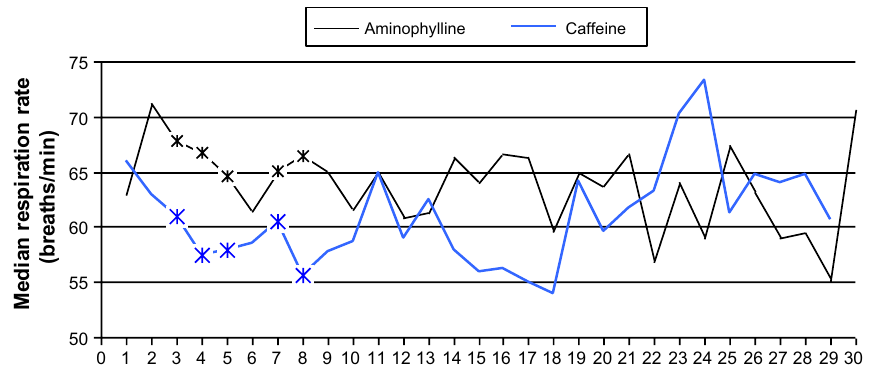
Note: The Wilcoxon two-sample test was used to analyse and determine statistical significance, and no statistical difference could be observed at the 5% Figure 5: Median mean arterial pressure in the two study groups